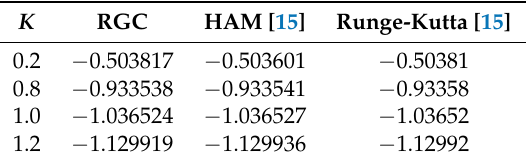
Table 6. Comparison of RGC, HAM and Runge-Kutta solution of C (cid:48) N = 0.8 and Sc = 0.24.